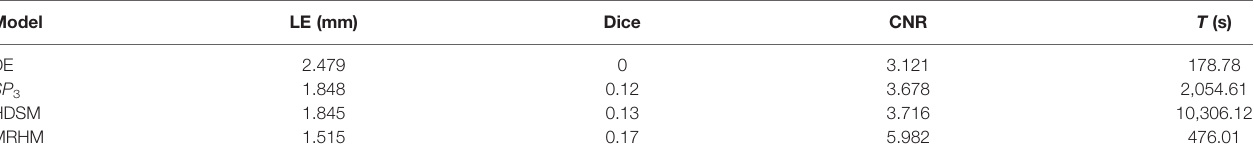
TABLE 5 | Quantitative results of the in-vivo